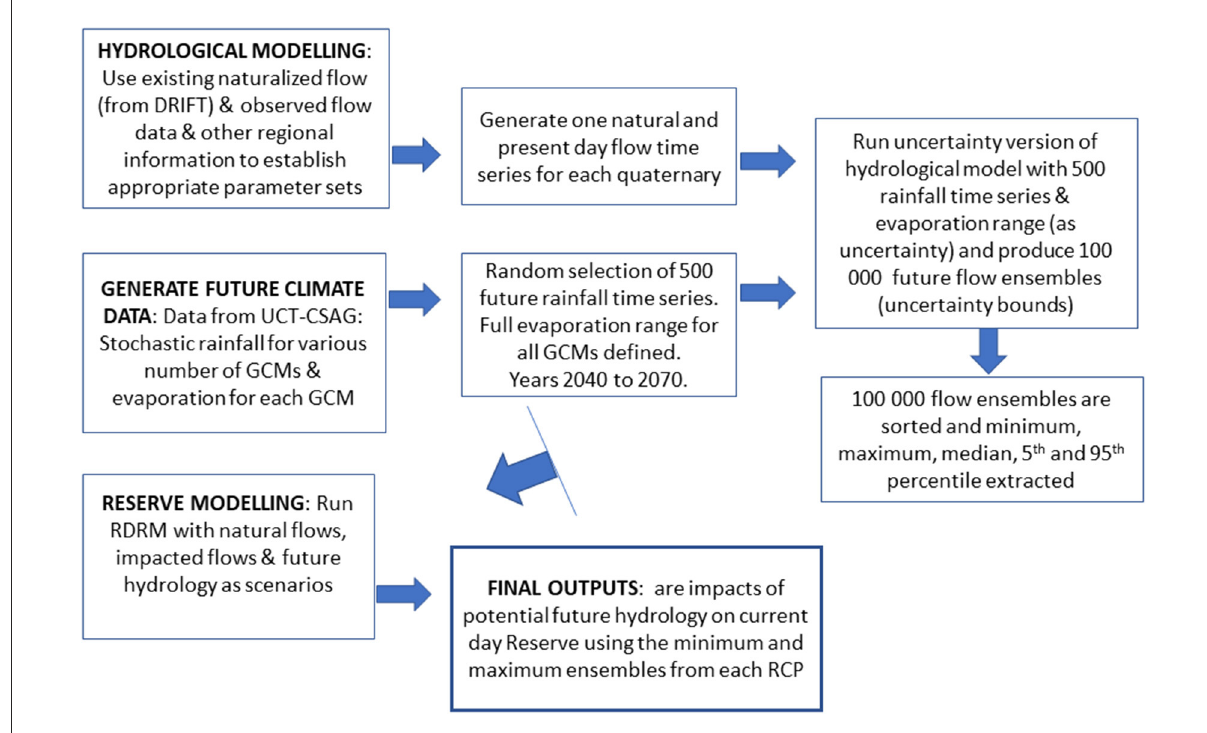
FIGURE2 Modeling framework showing the steps to incorporate climate data into the global options uncertain